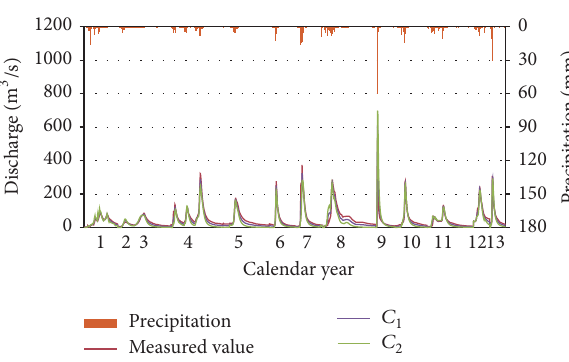
Figure 9: Comparison of the results of Luanchuan.